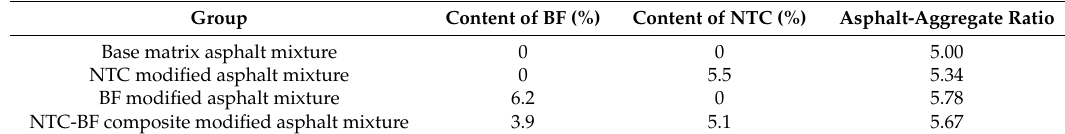
Table 3. Experimental design of asphalt mixtures.